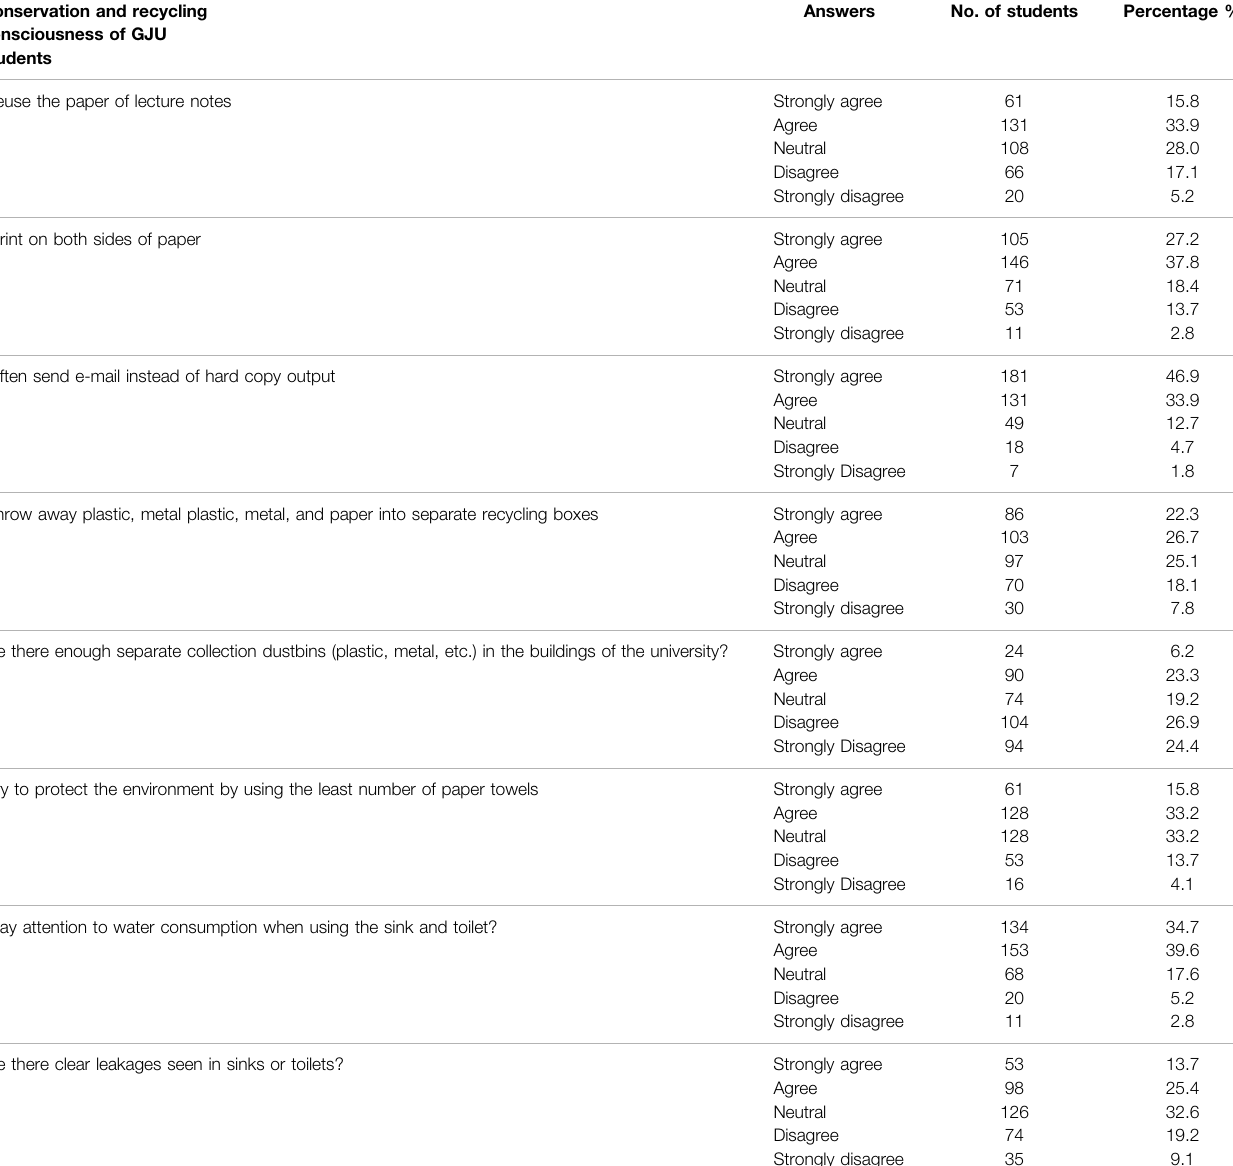
TABLE 2 | Conservation and recycling consciousness, questioner results for GJU students. Conservation and recycling consciousness of